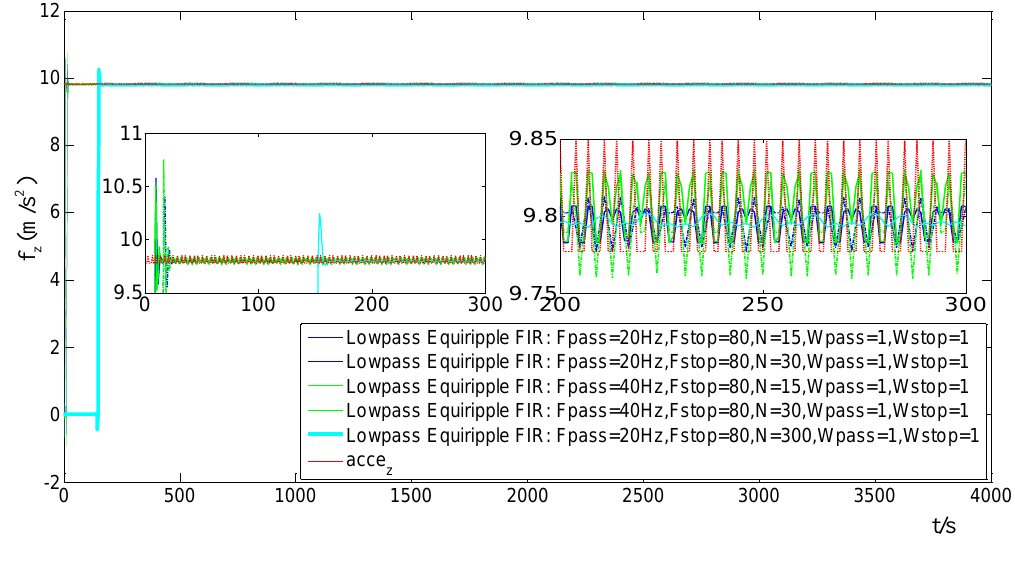
Figure 7. Filtering results with different filter parameters.